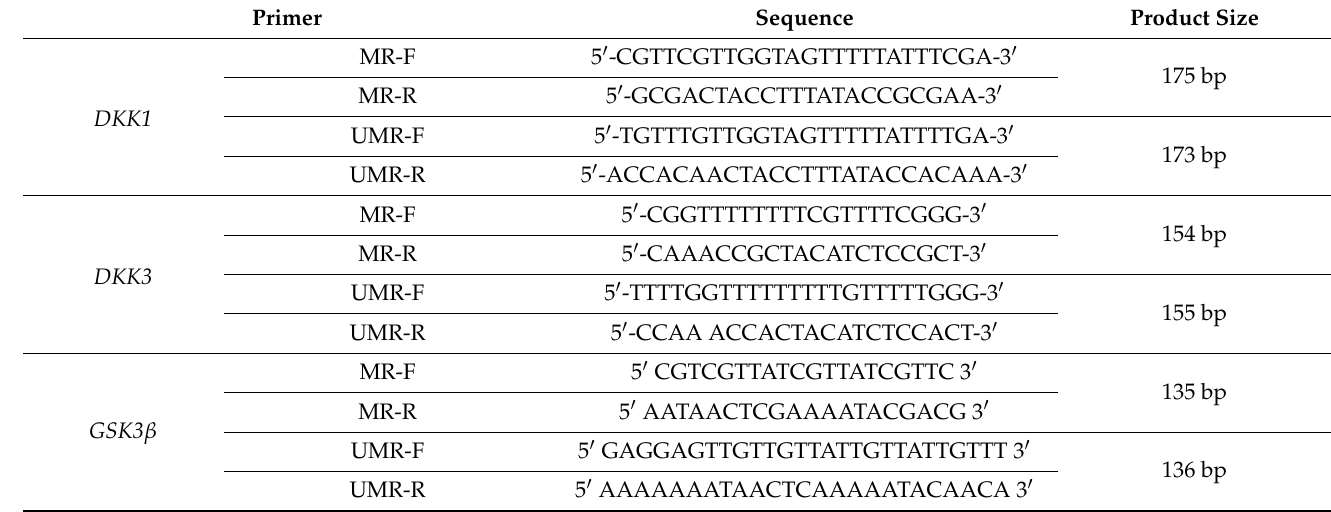
Table 1. PCR primers used for MSP.